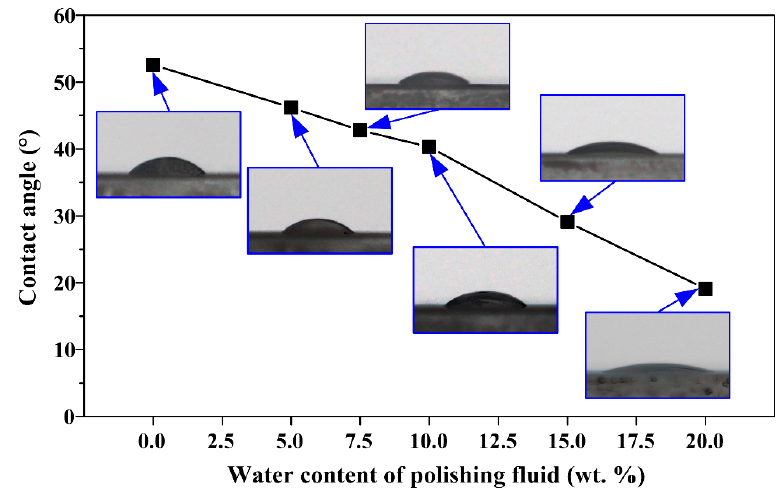
Figure 7. Contact angles of polishing fluid with different water contents on the KDP surface. According to Equation (1), in addition to the contact angle, the polishing fluid density